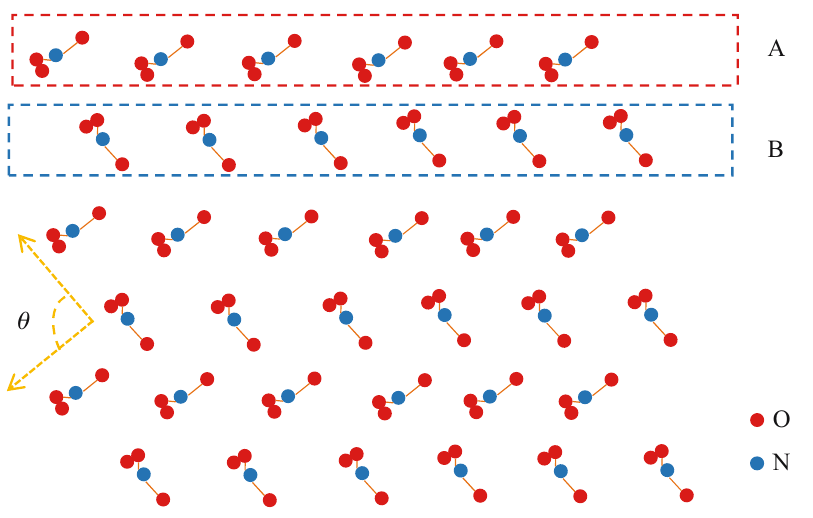
Figure 2: Arrangement of NO 3 groups in Re ( OH ) 2 NO 3